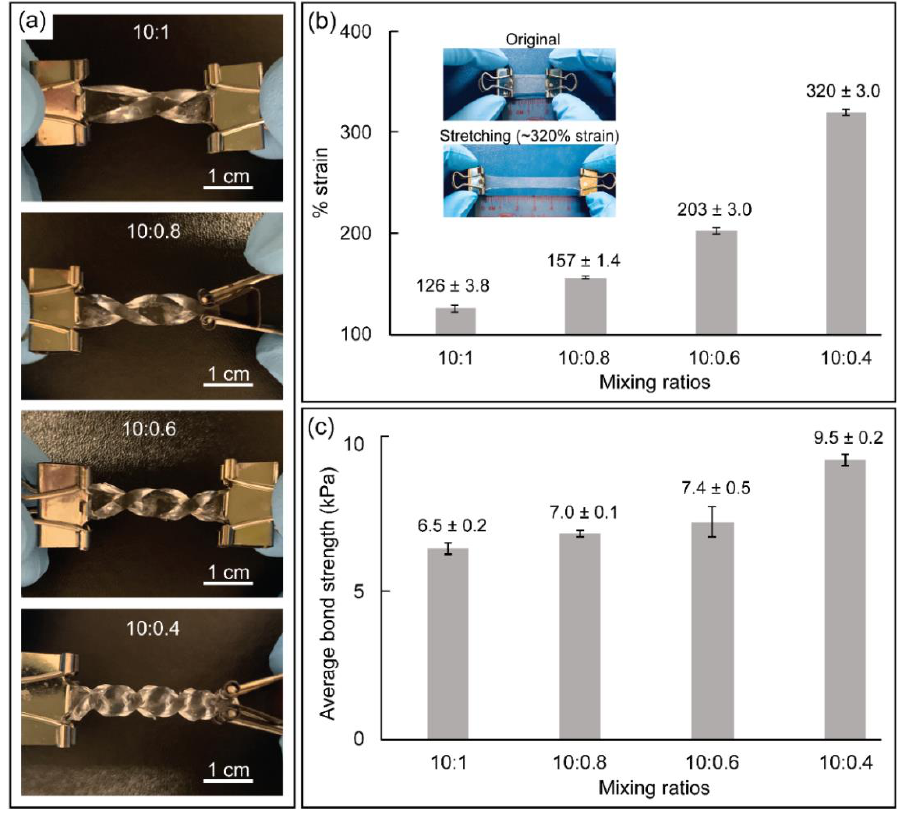
Figure 3. ( a ) Twisting test showing the flexibility of the PDMS fabricated with different mixing ratios of the pre-polymer and a curing agent. ( b ) Strain resolution of the PDMS substrate with different mixing ratios. The inset shows the photographs of the 10:0.4 ( w/w ) mixing ratio of PDMS substrate at different strains (original and stretching conditions). ( c ) Results of bond strength performed on PDMS – PDMS with different mixing ratios. All experiments were performed in triplicate.